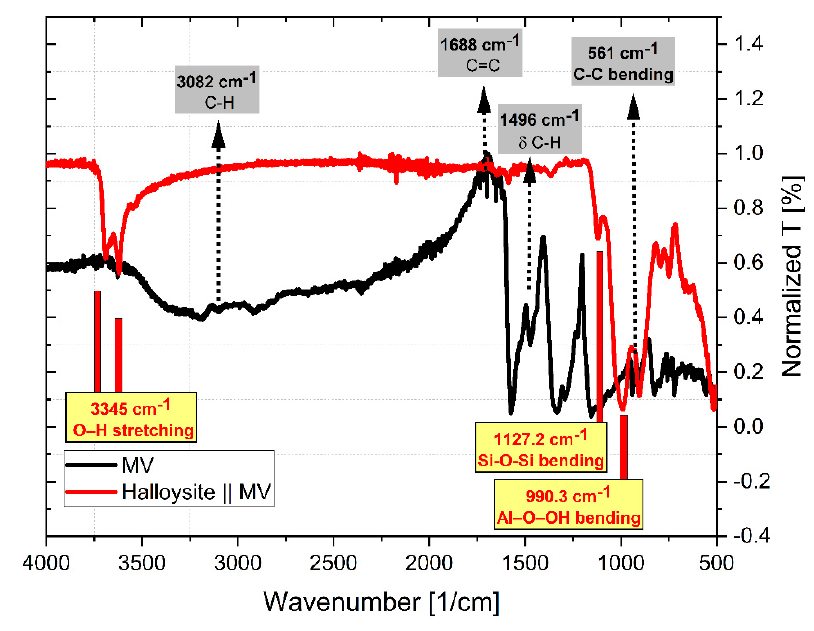
Figure 14. The FTIR spectrum of MV and MV-HNC.